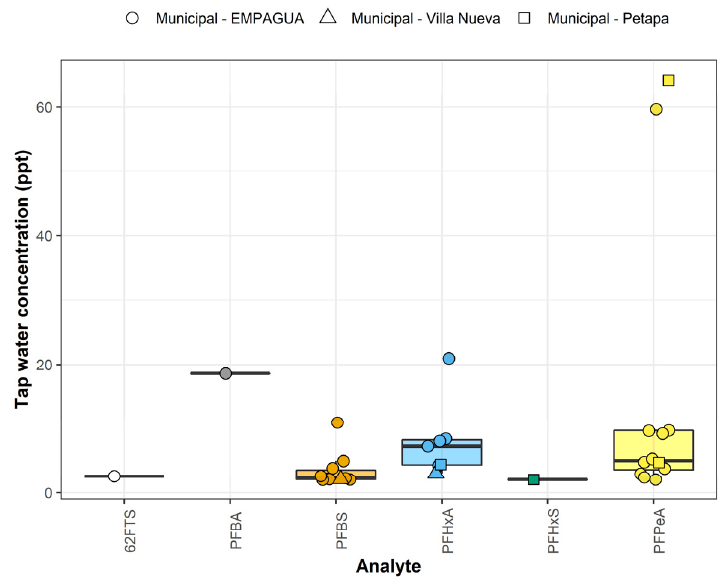
Figure 7. Distribution of individual PFAS analytes detected above the reporting limits in municipal tap waters in the Guatemala City metropolitan area. Horizontal lines of each box indicate the first quartile, median, and third quartile for each metal; vertical lines indicate the spread of the data up to ± 1.5 times the interquartile range from the first and third quartiles, with individual outliers shown.